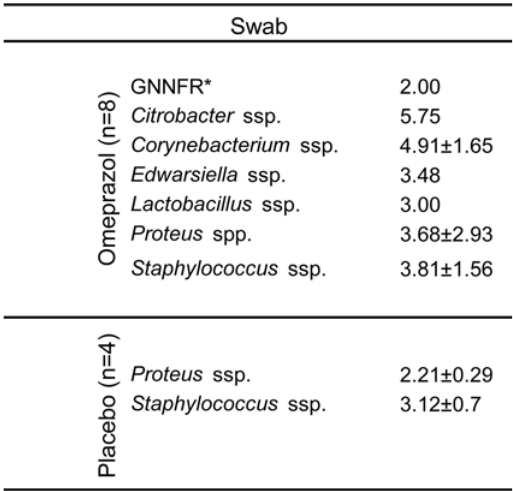
TABLE 6 - Bacteria strain [Ln(UFC/ml)] (mean ± SD or unit value) obtained by swab after administration of